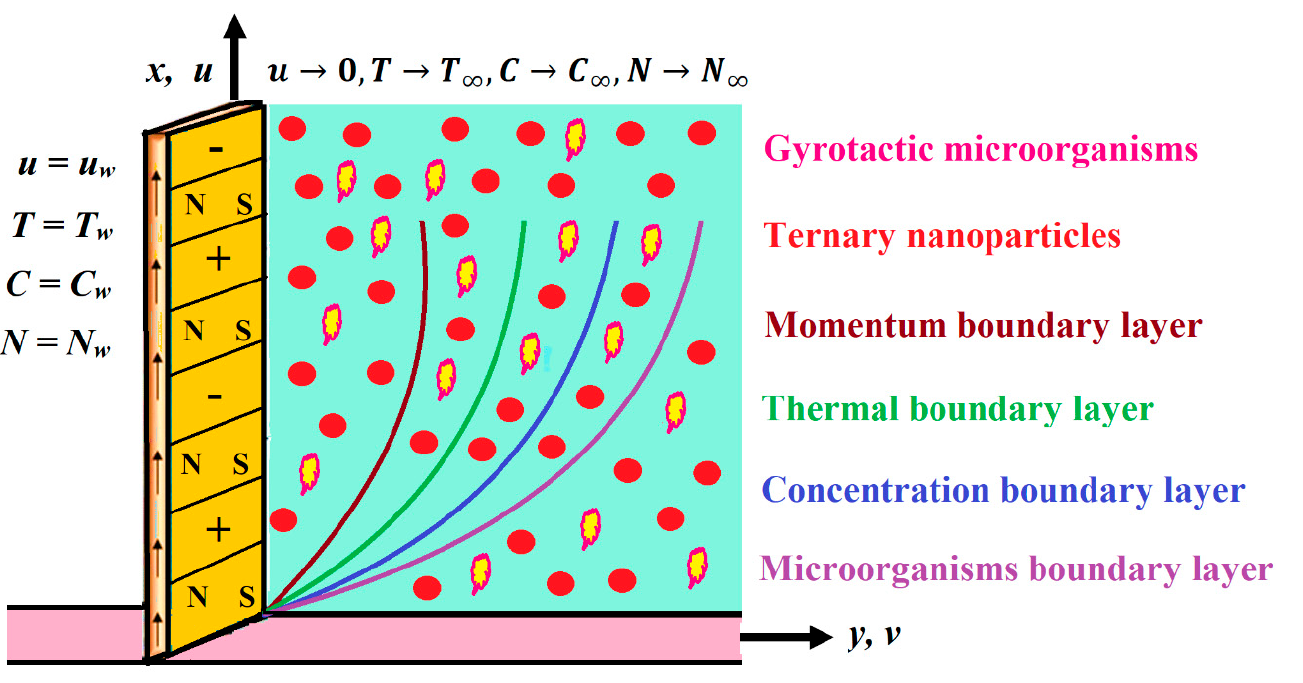
Figure 1. Geometry of flow configuration.